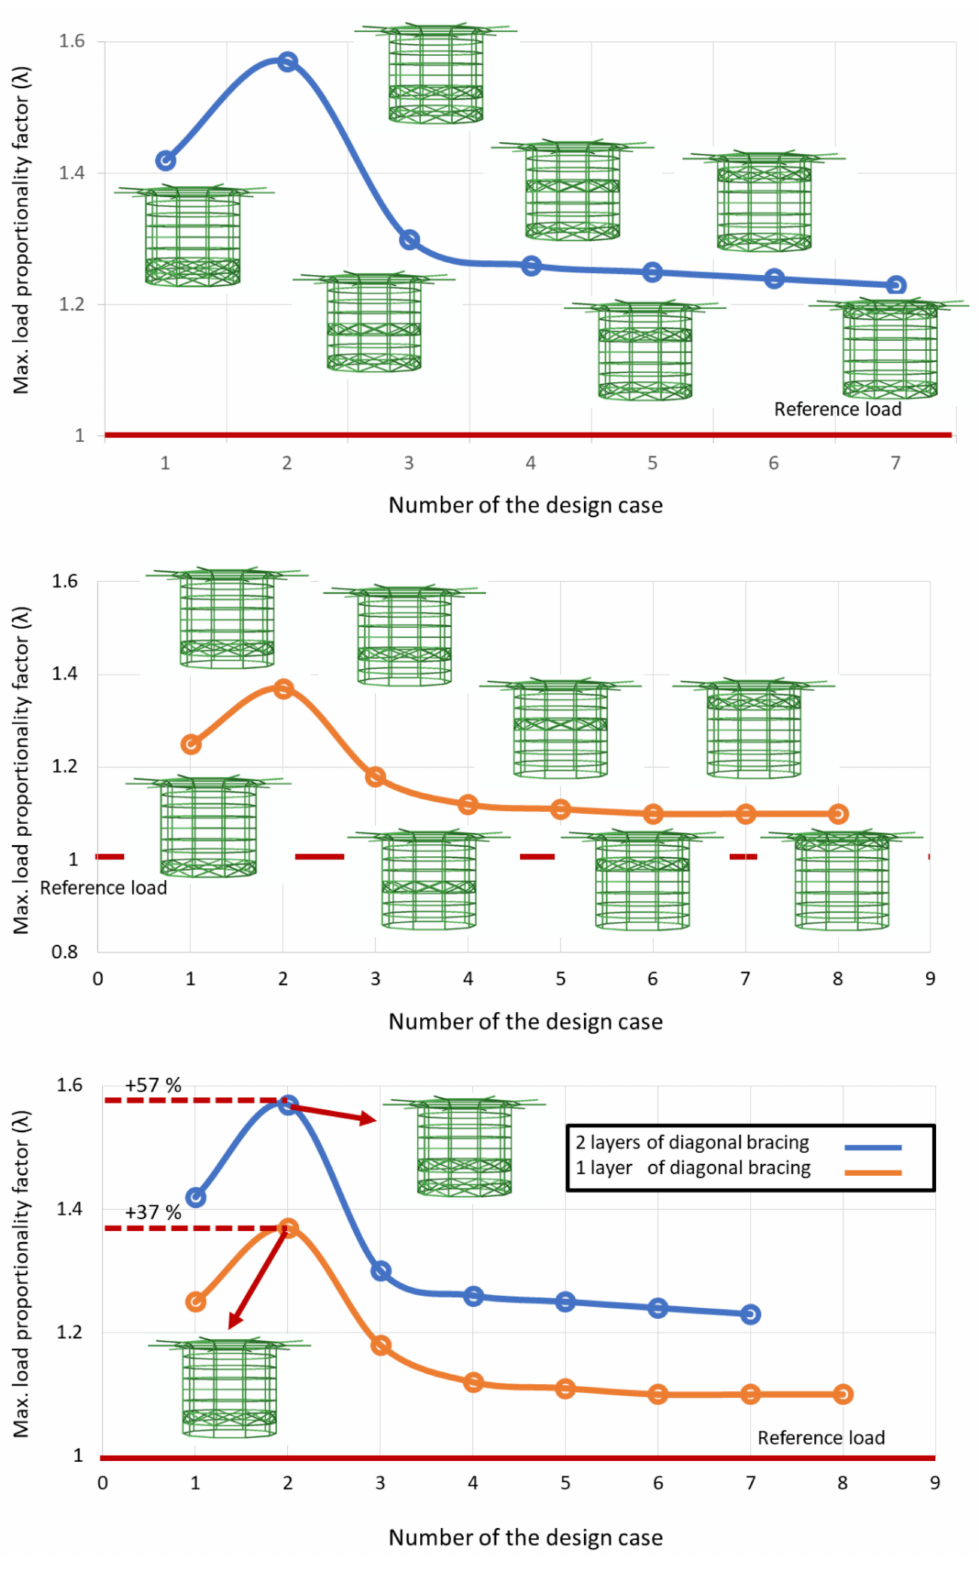
Figure 21. Maximum load proportionality factor for structures with one and two layers of diagonal bracing obtained from Riks analysis. ( Top ): the structures with two layers of diagonal components. ( Middle ): the structures with one layer of diagonal components. ( Bottom ): comparison of the load proportionality factor of the structures with one and two layers of diagonal